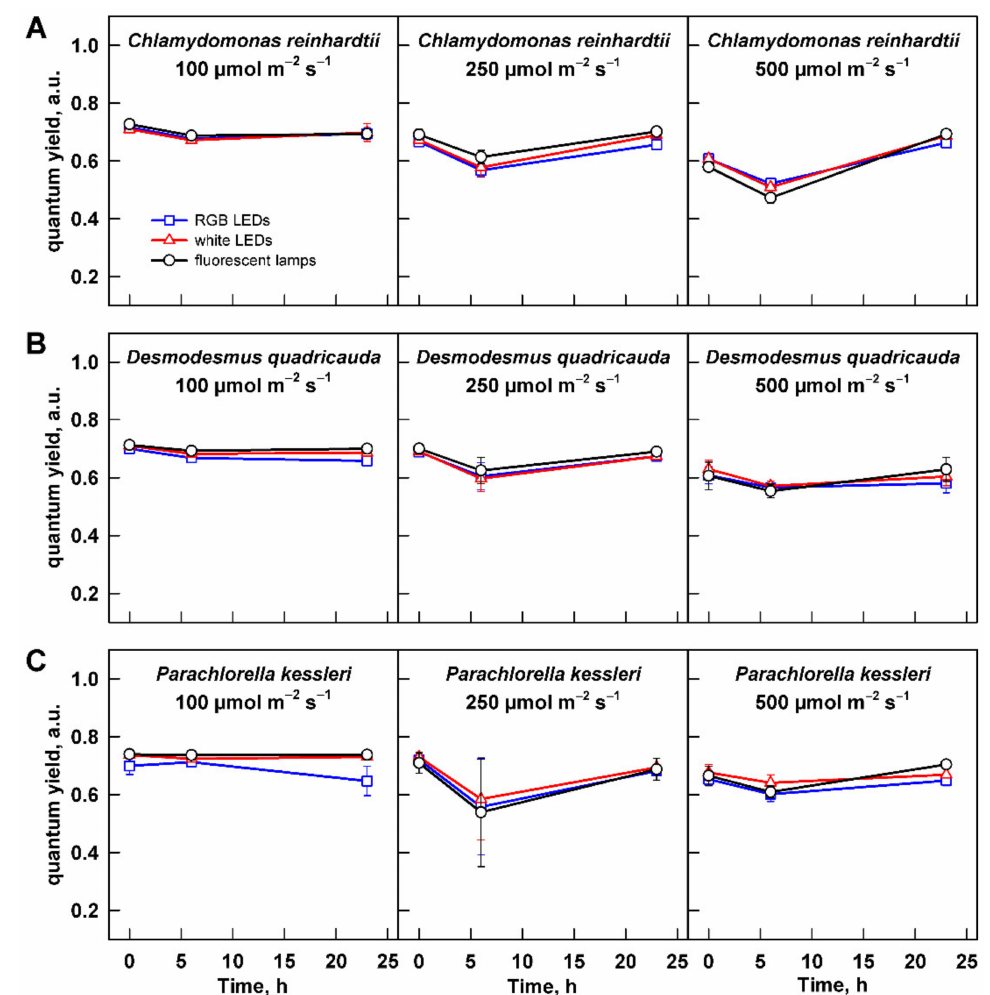
Figure 3. Quantum yield of the cultures grown at different light intensities. Cultures of ( A ) Chlamy- domonas reinhardtii , ( B ) Desmodesmus quadricauda , and ( C ) Parachlorella kessleri were grown at incident light intensity 100, 250, and 500 µ mol m − 2 s − 1 on different light sources: fluorescent lamps (black circles), RGB LEDs (blue squares), and white LEDs (red triangles). Data of three biological replicates are presented as means ±